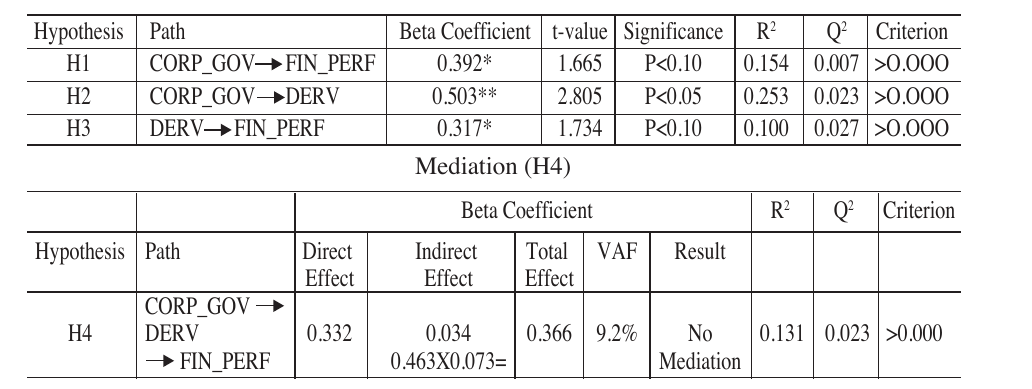
Table 16: Conditions of Mediation (H1 to H3)